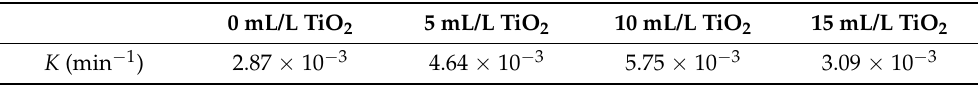
Figure 6. ( a ) The benzoic concentration after a certain duration of degradation on different electrodes, ( b ) the fitted curve for the BA degradation process, where C t is the BA concentration and C 0 is the initial BA concentration. Table 3. Degradation ability of Ti/SnO 2 -Sb 2 O x -TiO 2 electrodes with different concentrations of TiO 2 sol in electrolytes, where k is kinetics